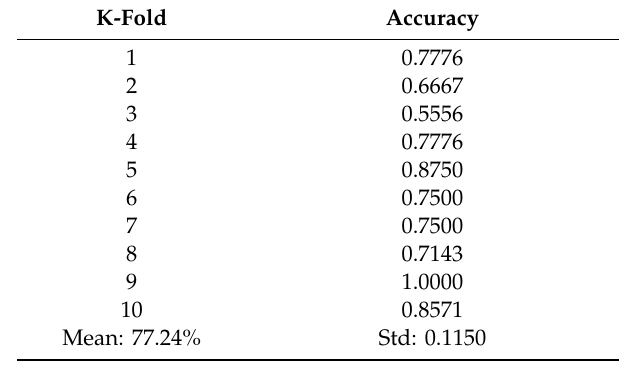
Table 6. Accuracies achieved by performing 10-Fold Cross-Validation on the SVM-Linear model.